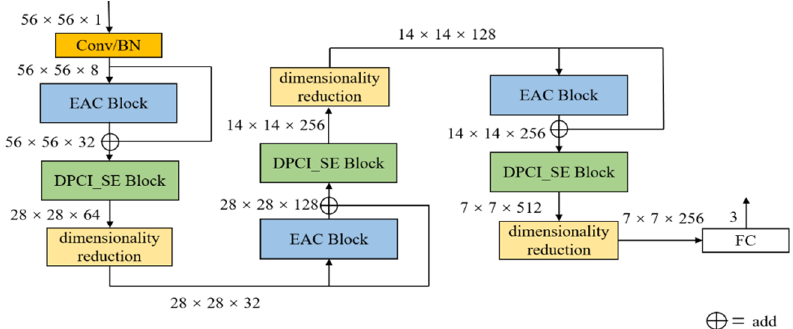
Figure 2. The structure of ED Net.